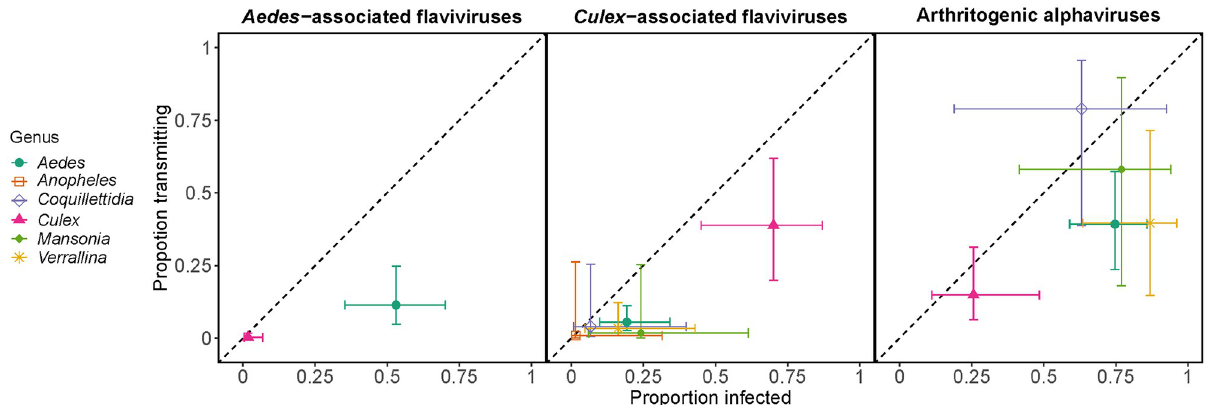
Fig 2. Estimated proportion of mosquitoes (grouped by genus: color) infected by (x-axis) and transmitting (y-axis) three virus groups (panels). Points show mean estimates and intervals show 95% credible intervals (CI) at the overall mean (across all experiments) dose and one SD above the overall mean DPE, obtained from the logistic regression models. Non-overlapping horizontal and vertical CI between two mosquito genera for a given viral group indicate statistically different infection and transmission capabilities, respectively, for those genera.